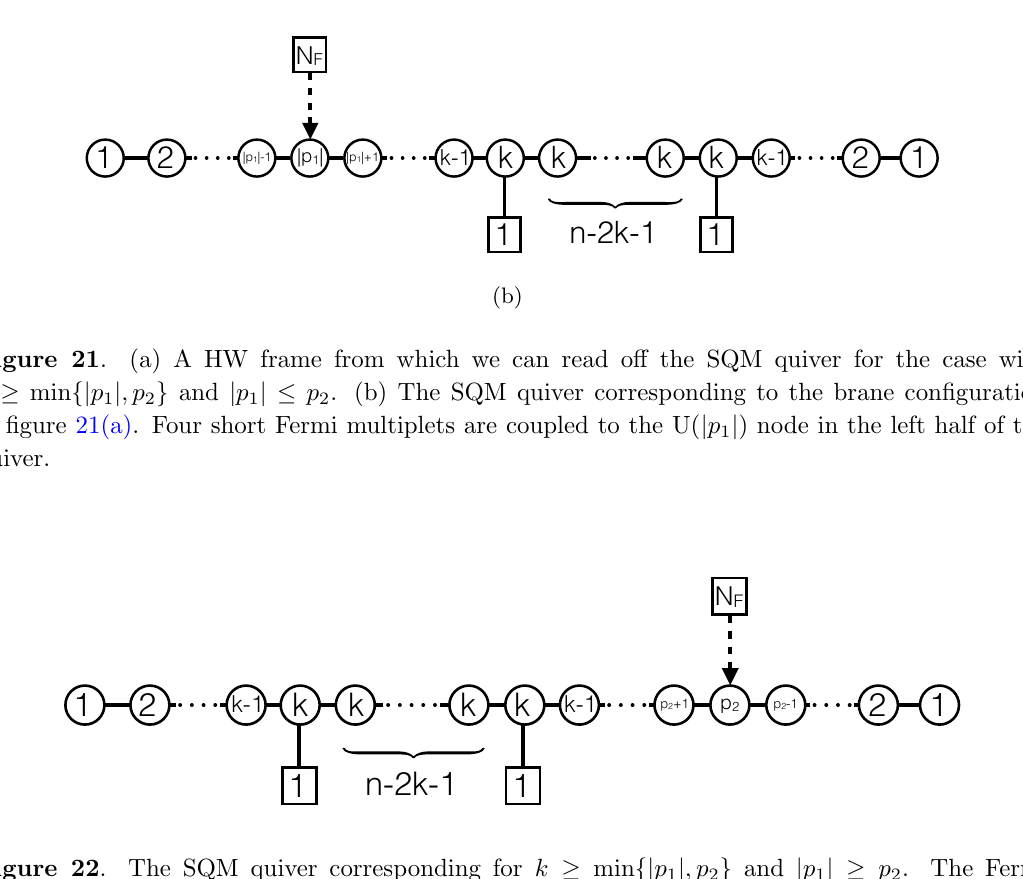
Figure 22 . The SQM quiver corresponding for k (cid:21) min fj p 1 j ; p 2 g and j p 1 j (cid:21) p 2 . The Fermi multiplets are coupled to the U( p 2 ) node in the right half of the